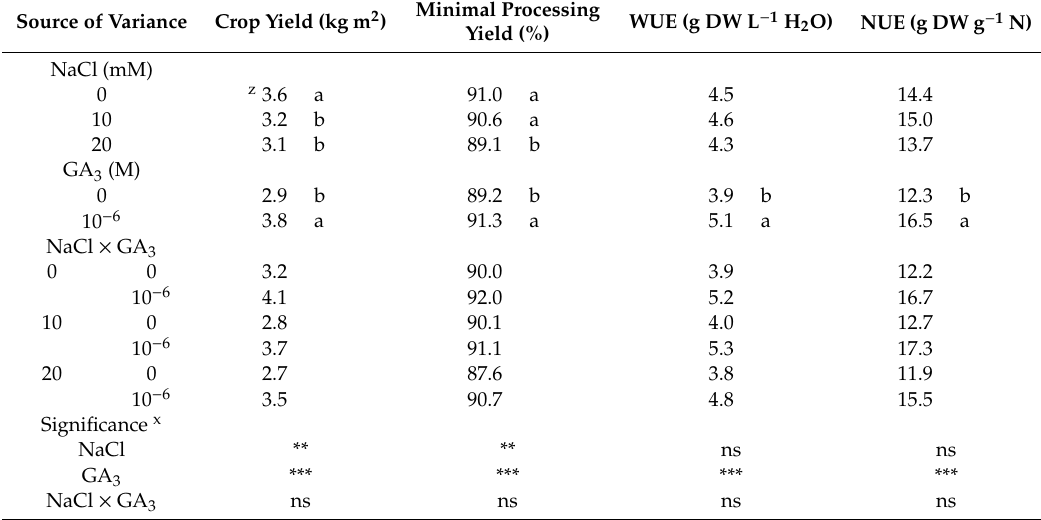
Table 2. Yield parameters of leaf lettuce plants grown in nutrient solutions containing di ff erent levels of NaCl and GA 3